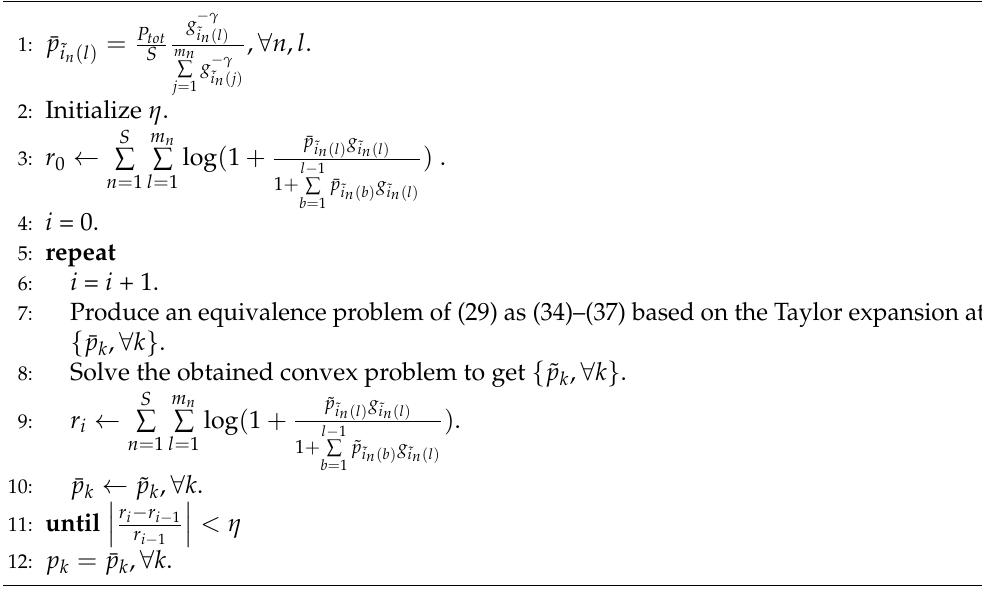
Algorithm 4 Power Allocation Scheme for MIMO-NOMA